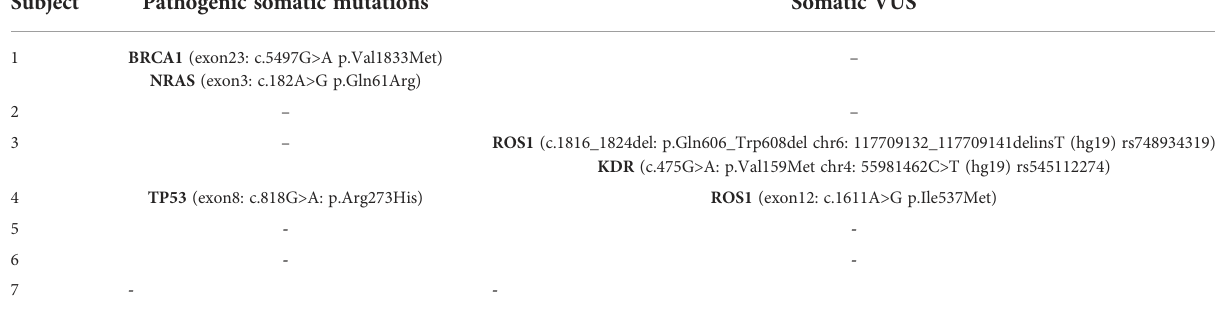
TABLE 4 Somatic mutations in patients with